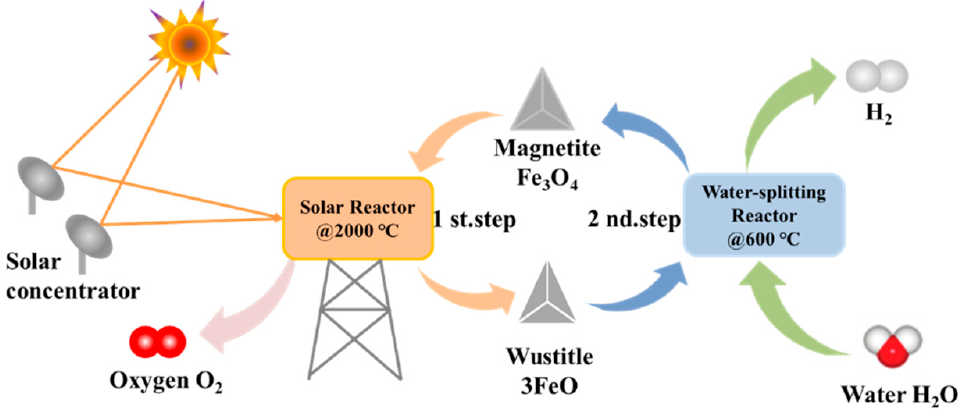
Figure 3. Schematic for two-step solar thermochemical water-splitting using Fe 3 O 4 /FeO redox system. Adapted with permission from Ref. [47], Copyright 1999, Elsevier.